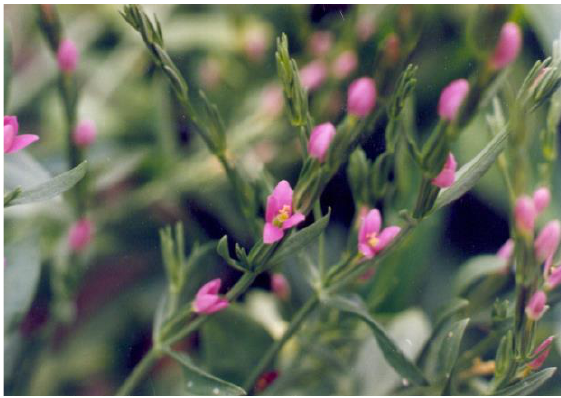
Figure 1. Centaurium spicatum flowering tops of individuals from nature.